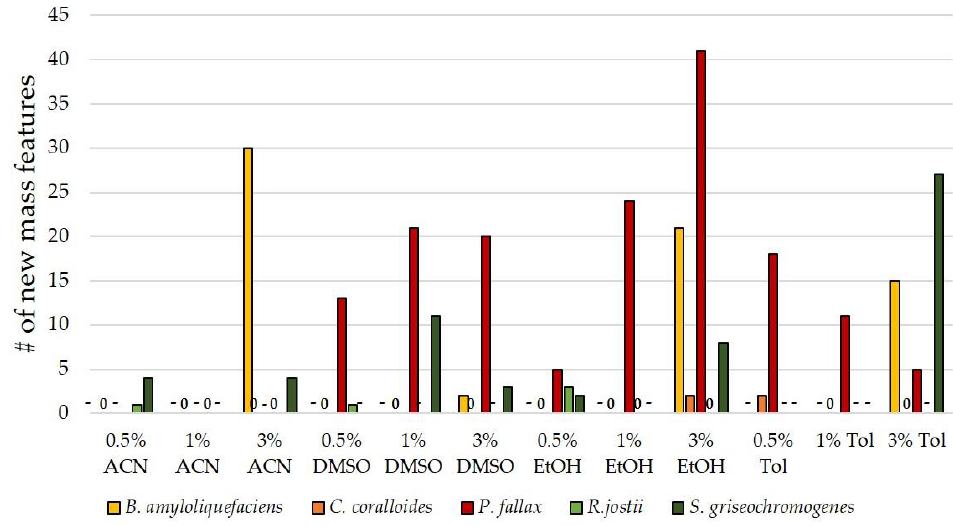
Figure 4. Number of new mass features in extracts of solvent supplementation experiments. Entries marked with ‘-’ were not tested and ‘0’ indicates no new mass features with this bacterium. Any new mass feature had to be present in both biological duplicates and its MS signal had to surpass an intensity of 10 5 to be considered for the number of new mass features presented in this diagram. Therefore, this diagram only shows the number of reproducibly detected mass features. DMSO, dimethyl sulfoxide; ACN, acetonitrile; Tol, toluene; EtOH, ethanol.